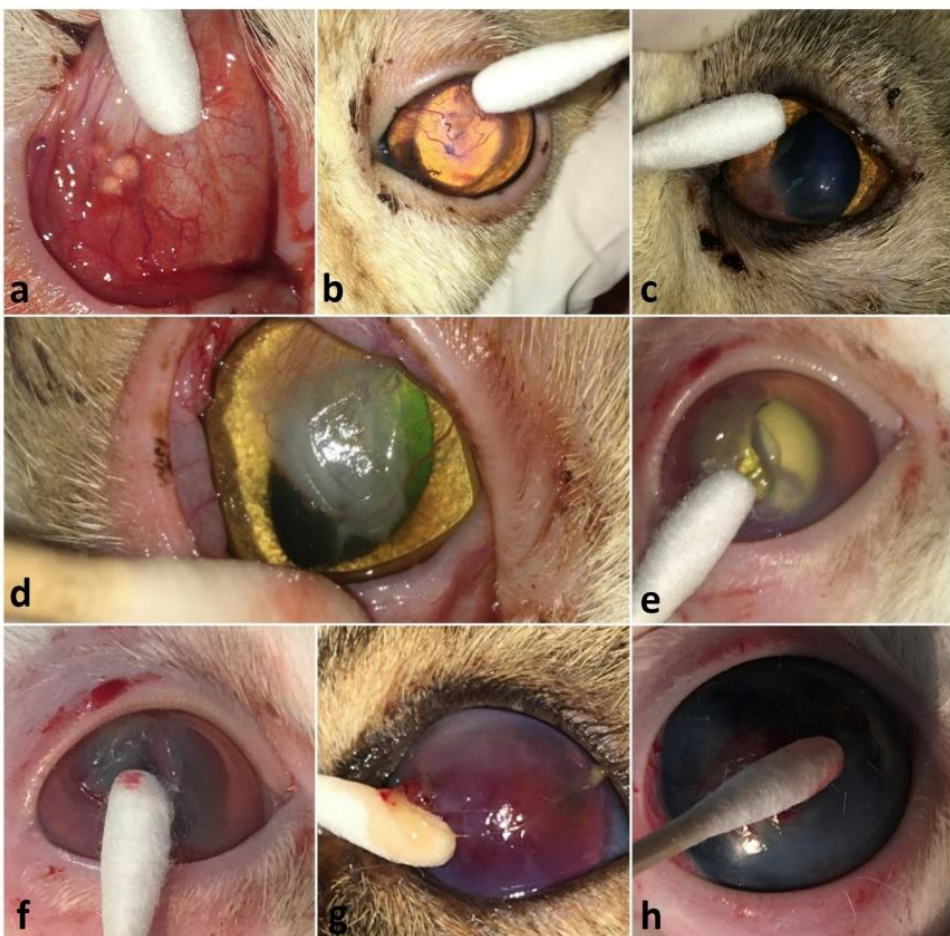
Fig. 1: Photographs showing the clinical presentation and sampling technique from cats with keratoconjunctivitis (a,b,c and d), corneal ulcers (e and f), corneal perforation and endophthalmitis (g) and chronic incurable glaucoma (h).